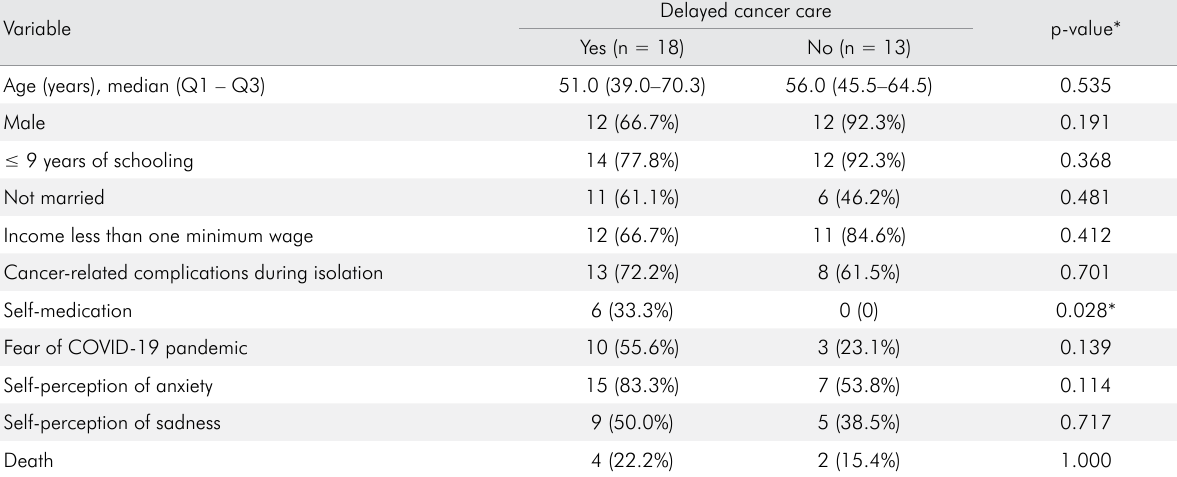
*p-values less than 0.05 were considered statistically